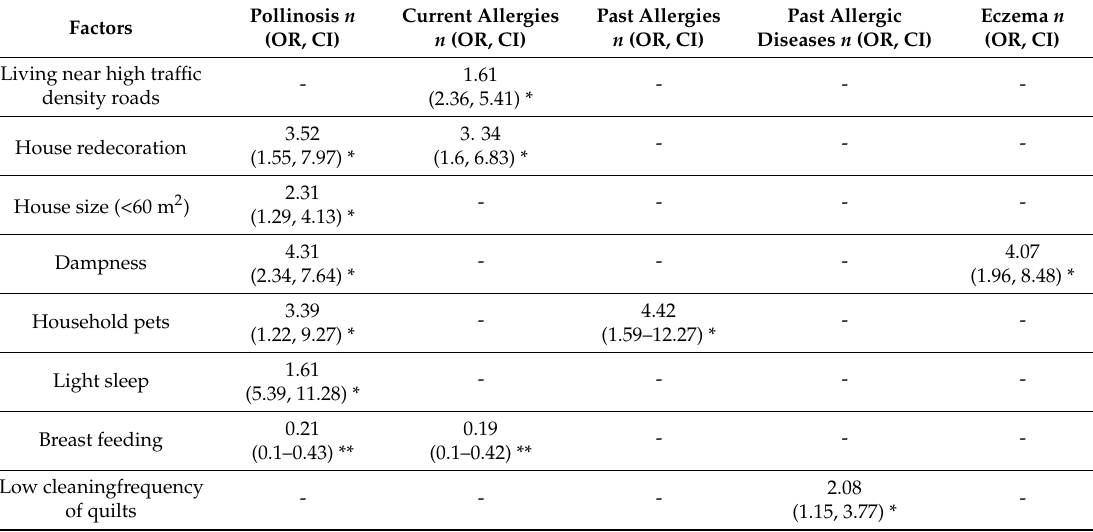
Table 2. Multivariate logistic regression analysis of the dwelling environment, lifestyles and